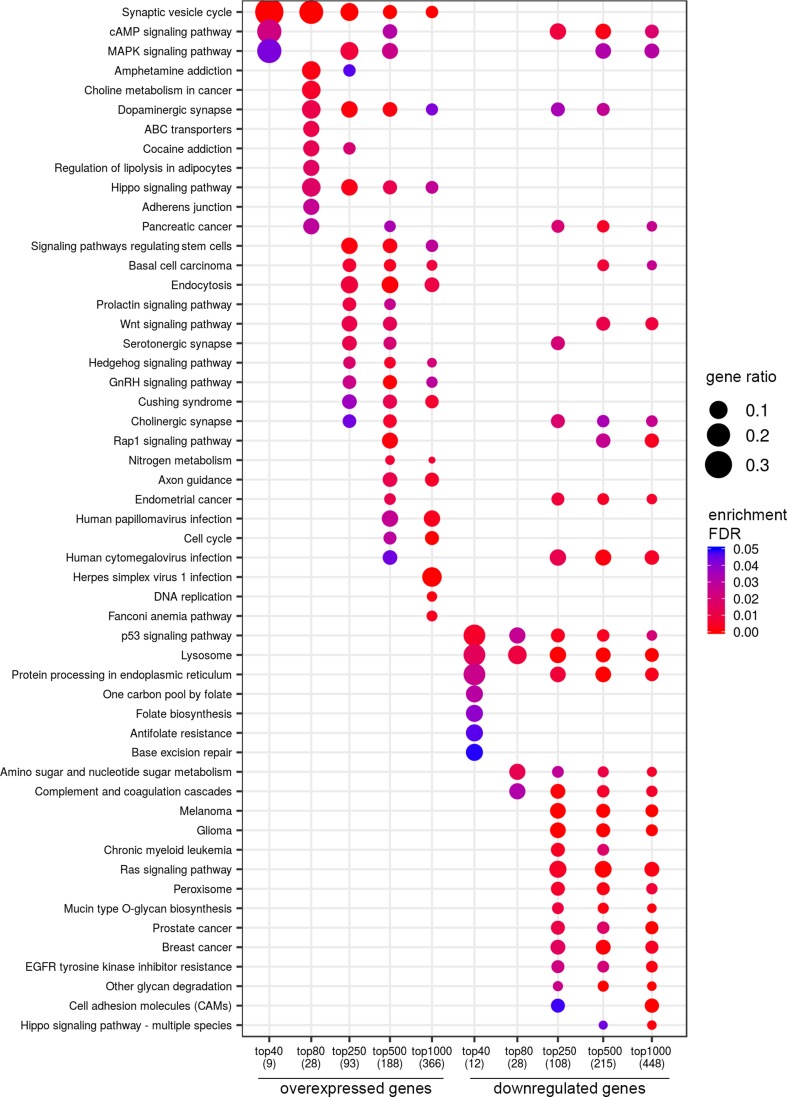
Dotplot showing the results of KEGG pathways enrichment analyses performed for top-40, 80, 250, 500, and 1,000 differentially expressed genes (either overexpressed or downregulated) between the groups of adverse and favorable prognosis (TCGA data; TMPRSS2-ERG-positive samples). All the genes have passed the following thresholds: DESeq p-value < 0.01, Mann–Whitney p-value < 0.05, average expression-level fold change > 25%. Dot size indicates k/n ratio (“gene ratio”), where k is the number of genes participating in the current KEGG pathway (within top-40, top-80, or other top lists), and n is the number of genes (also within top-40, top-80, or other top lists) annotated as participants of any KEGG pathway (these numbers are provided in the brackets in the bottom of the figure). Dot color indicates the enrichment test FDR (Fisher’s exact test).